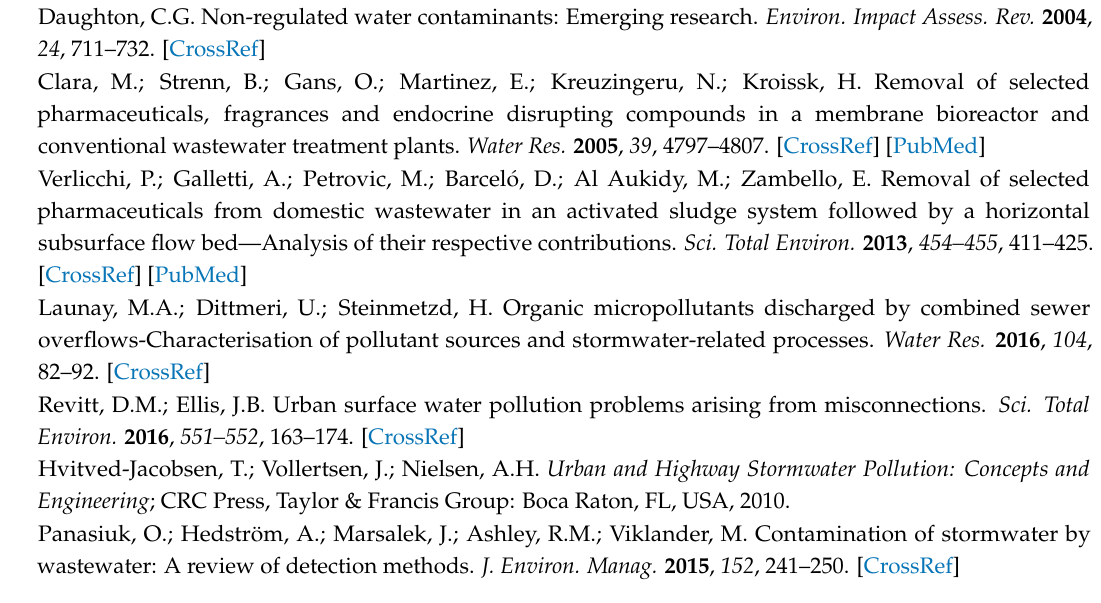
Figure S1: Vertical profile of aerobic (AE), anaerobic (ANAE) and undisturbed (RE) microcosms before and after incubation in terms of redox potential (left), pH (middle) and dissolved oxygen concentration (right), Table S1: Properties of the sediment, Table S2: Identification of the selected pharmaceuticals in SIM mode by LC-MS, Table S3: Limit of detection and quantification of the compounds in water and sediments, Table S4: Freundlich model fitting result and sediment-water distribution coefficient. Kf ( µ g1-1/n L1/n g-1), Kd (L kg-1), Table S5: The fitting results of first-order decay